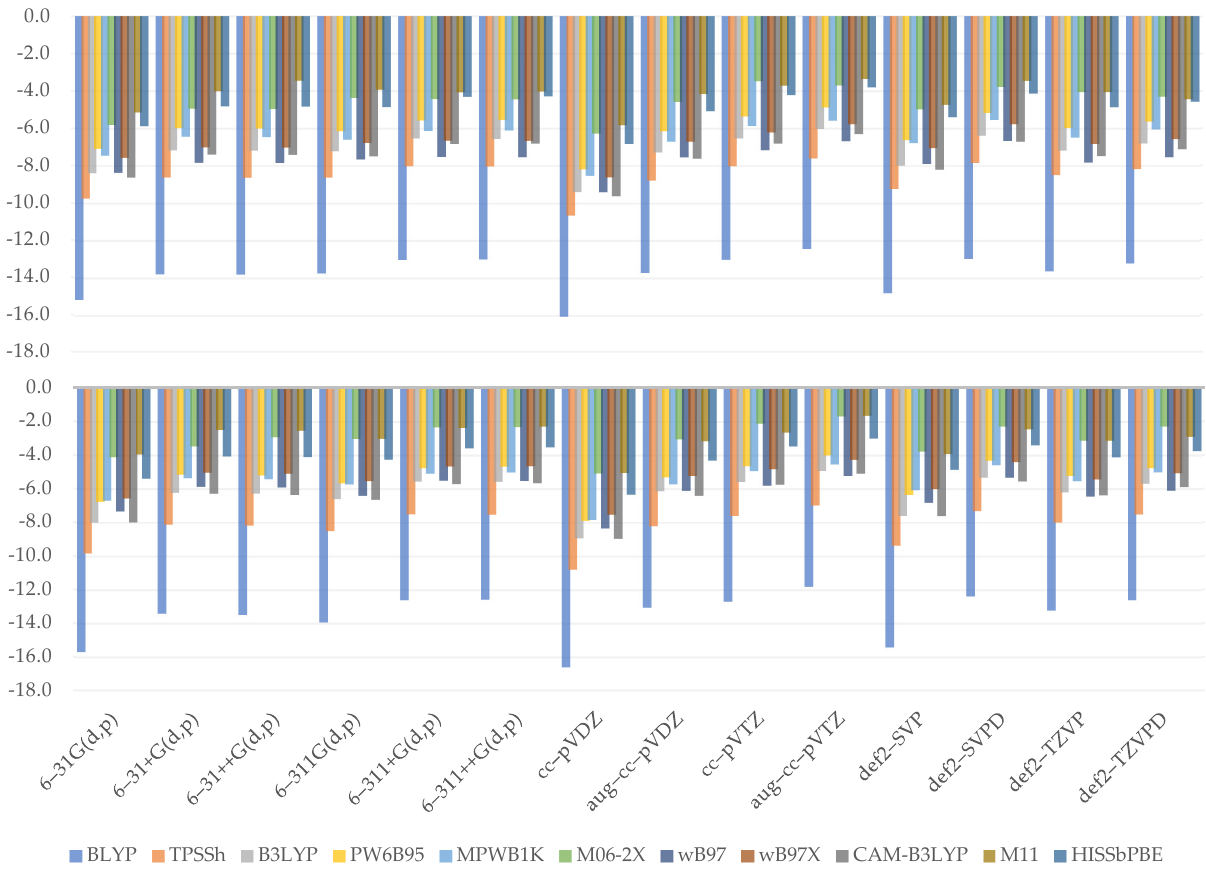
Figure 2. Relative errors to the reference value for C3 ( upper ) and C4 ( lower ) hydroxyl bond dissociation enthalpy. (kcal/mol).